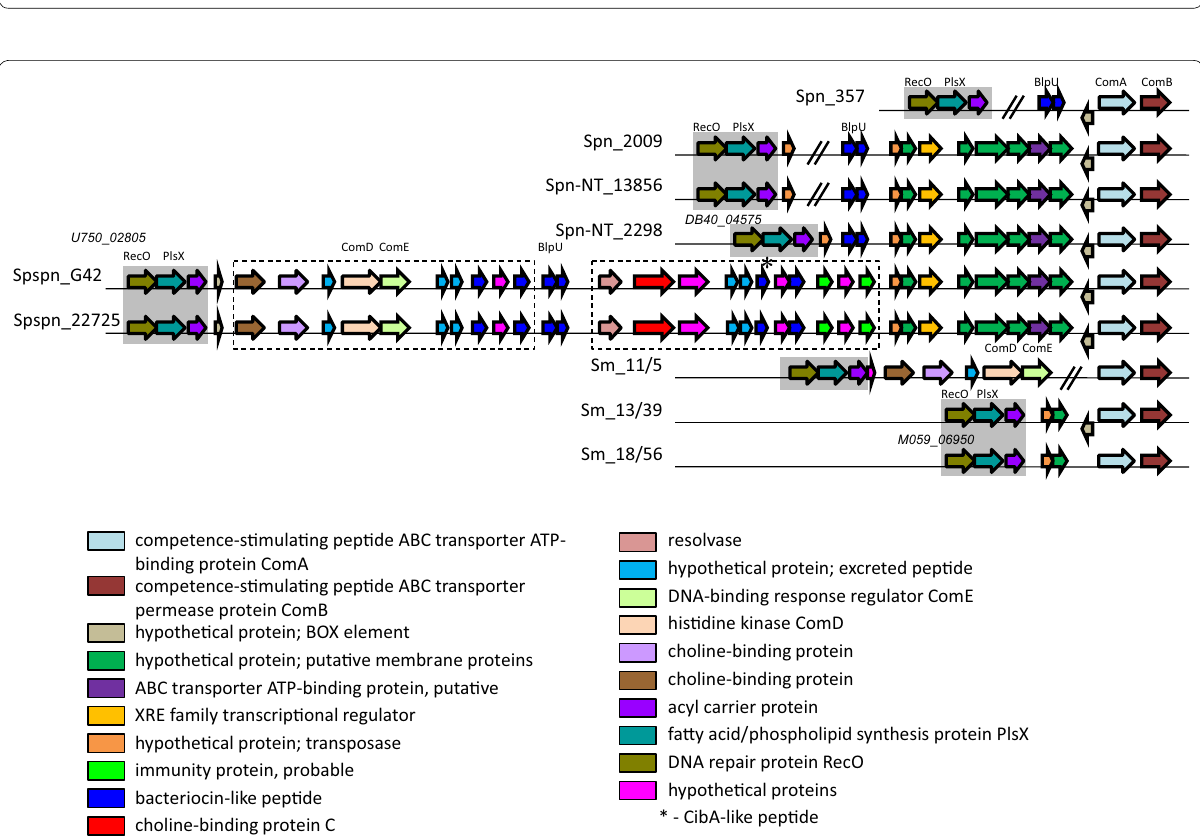
Fig. 5 Reconstruction of the “ S. mitis ” gene cluster structure. Homologous genes in compared samples are indicated by the same color. Grey fields highlight homologous fragments in different genomes. Double slash indicates the gaps in the nucleotide sequence (a point of joining of two con- tigs). NCBI identifiers of the first gene in locus are given for Spn-NT_2298, Spspn_G42 and Sm_18/56,